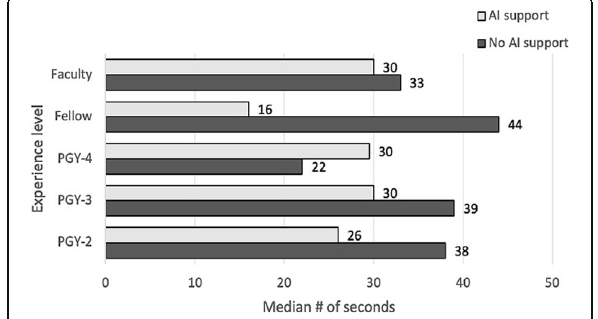
Fig. 5 Median number of seconds spent with and without AI support per user experience